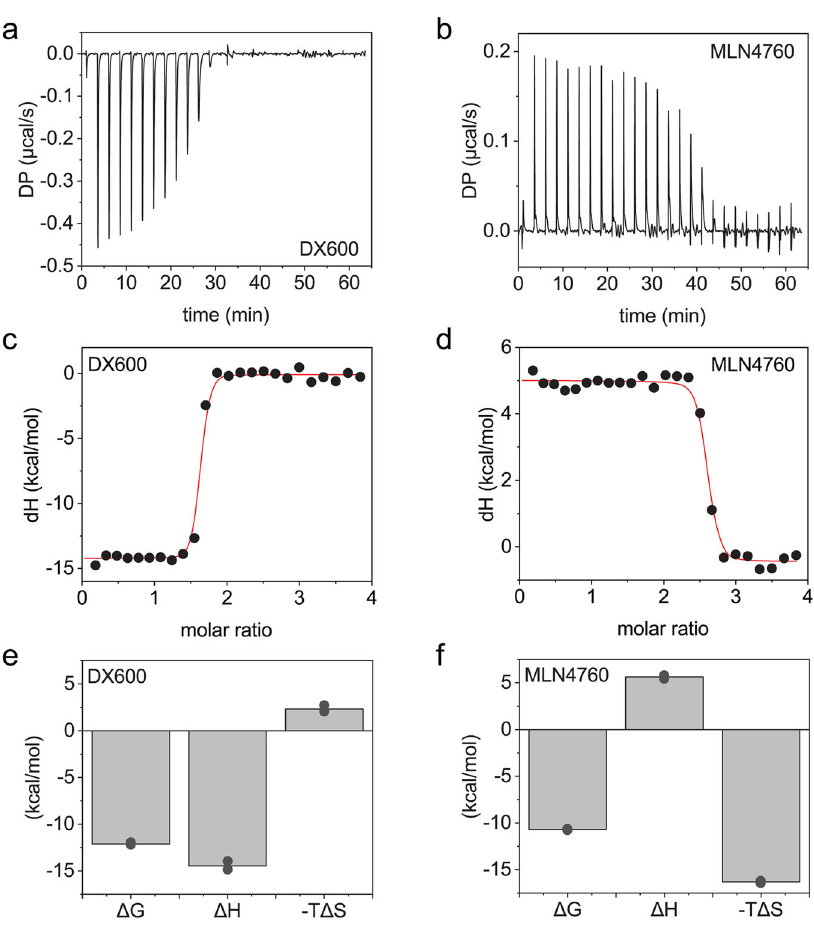
Fig. 3 Binding of enzyme inhibitors to ACE2-IgG4-Fc. ITC measurements to assess the binding of ( a ) DX600 and ( b ) MLN4760 to ACE2-IgG4-Fc. Fits to the ITC data obtained with ( c ) DX600 and ( d ) MLN4760. The red lines are fi ts to the experimental data. Thermodynamic parameters of the binding of ( e ) DX600 and ( f ) MLN4760 to ACE2-IgG4-Fc. The bars are mean values of duplicates. The values from each replicate are shown in circles.